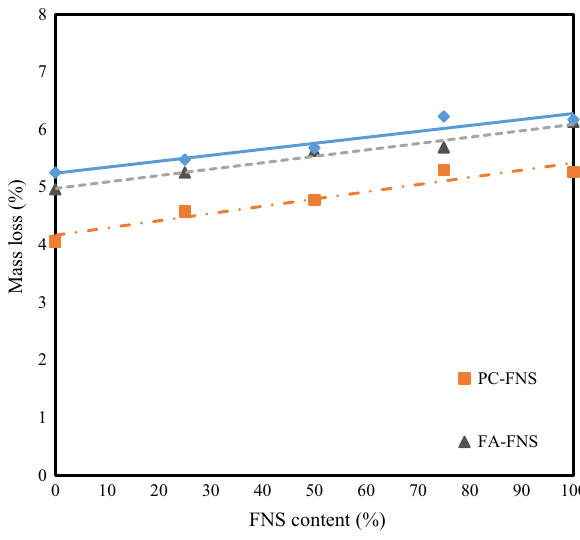
Fig. 9 Mass loss due to wet–dry